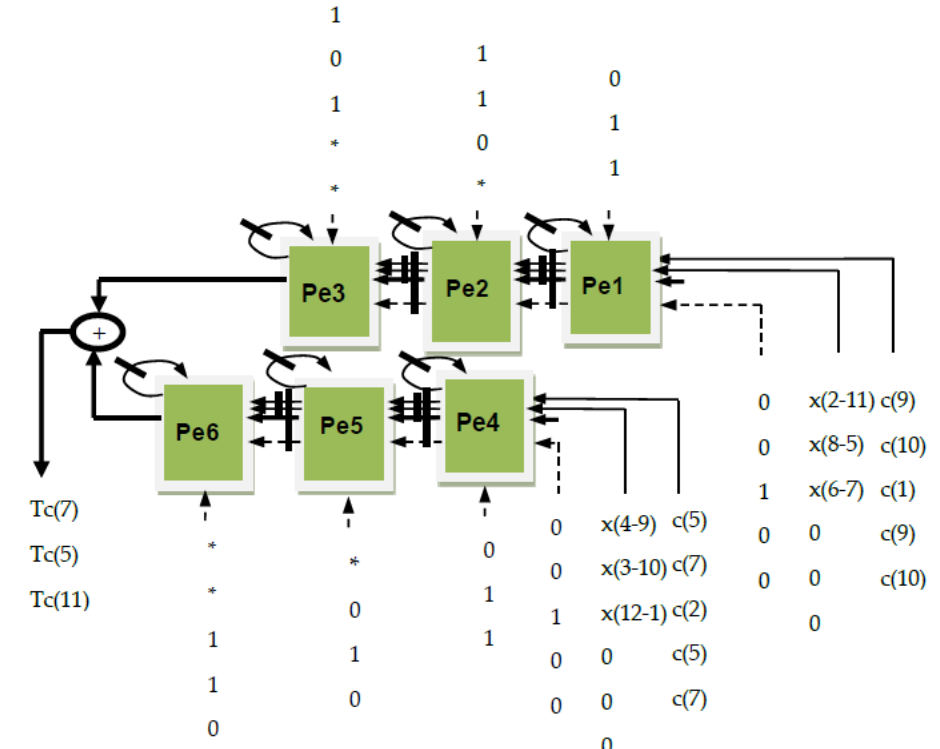
Figure 4. The VLSI architecture of the hardware core that implements Equation (11), where * marks a delay of one clock cycle [26].